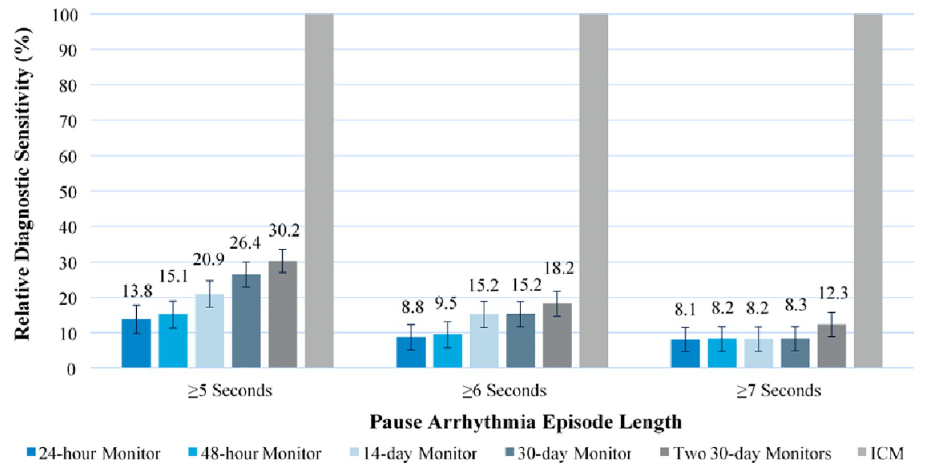
Fig 2. Sensitivity of conventional monitoring strategies to diagnose patients with pause arrhythmias relative to ICM. Data represent mean ± standard deviation from 1,000 simulations. Abbreviations: ICM, insertable cardiac monitor.